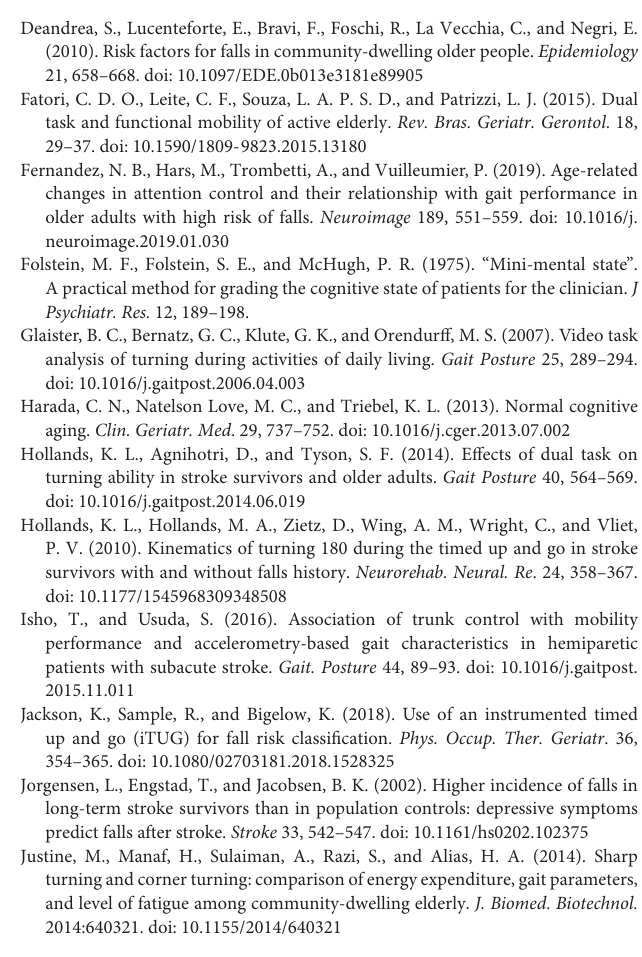
TABLE S2 | Three-way ordinary ANOVA summary. This was used as a first step to explore the dataset. TABLE S3 | Significant correlations between SPARC, demographics, and functional